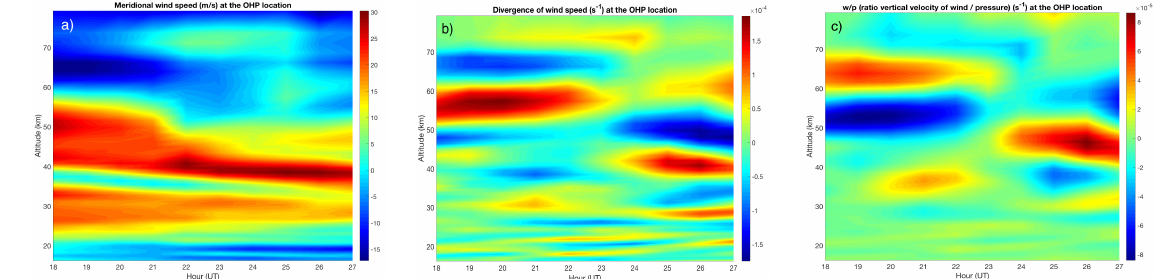
Figure 13. ( a ) Meridional wind speed in m.s − 1 from ERA5 data. ( b ) Divergence of wind speed in s − 1 from ERA5 data. ( c ) Vertical wind speed (in Pa.s − 1 divided by pressure (in Pa)).